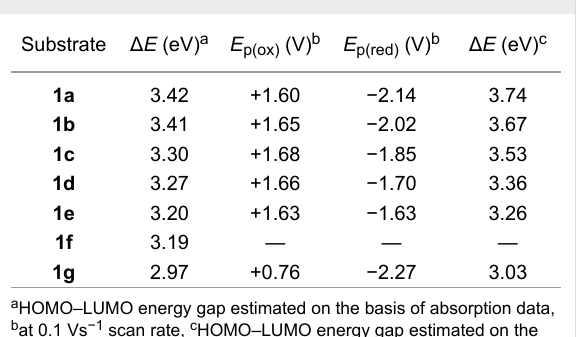
Table 2: HOMO-LUMO energy gap and change in dipole moment due to ICT.